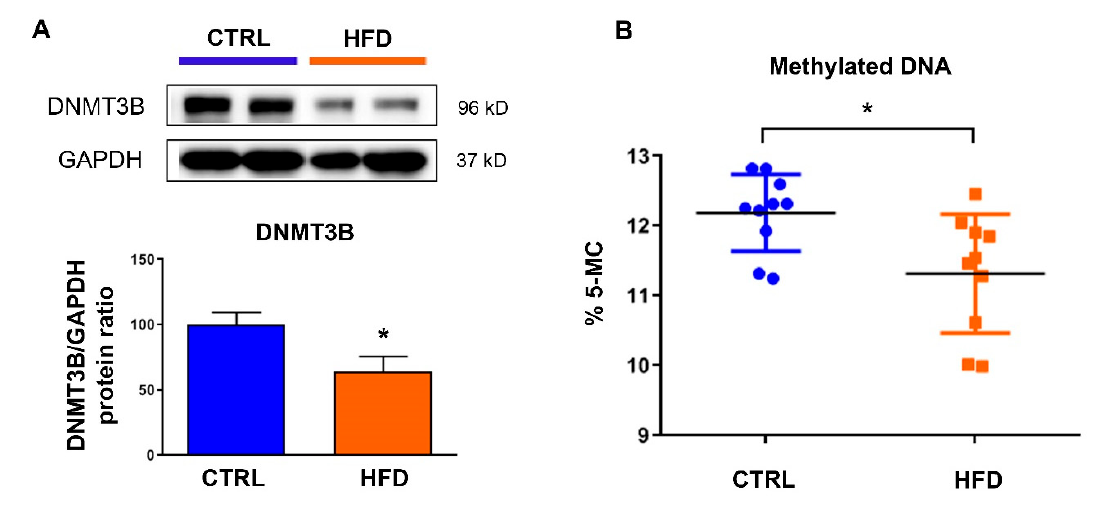
Figure 2. E ff ects of maternal exposure to high-fat diet on cardiac DNA methylation. ( A ) Protein levels of DNA methyl transferase 3B (DNMT3B) were analyzed in the heart from male rat at postnatal day 77 under control chow diet (CTRL) or high-fat diet (HFD). Representative immunoblot image is presented Data are expressed as the mean ± SEM; n = 13 per group. * p < 0.05 compared to control. ( B ) Global DNA CpG methylation levels was measured in the heart of animals under control chow diet (CTRL) or high-fat diet (HFD). Data are expressed as the mean ± SEM; n = 10 per group. * p < 0.05 compared to control.